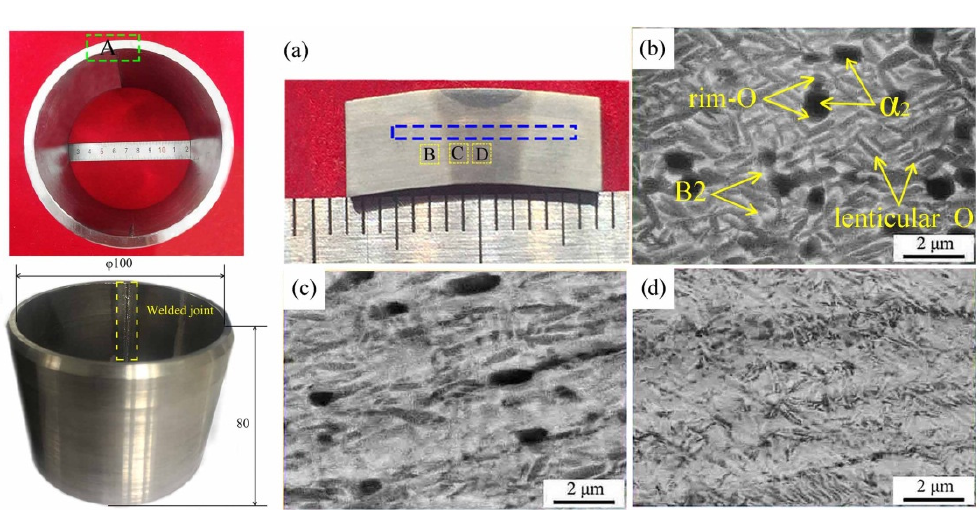
Figure 4. Microstructure of the as-welded joint (SEM micrograph): ( a ) Cross section of the as-welded joint, ( b ) SEM image of zone B (BM) in ( a ), ( c ) SEM image of zone C (HAZ) in ( a ), ( d ) SEM image of zone D (FZ) in ( a ).